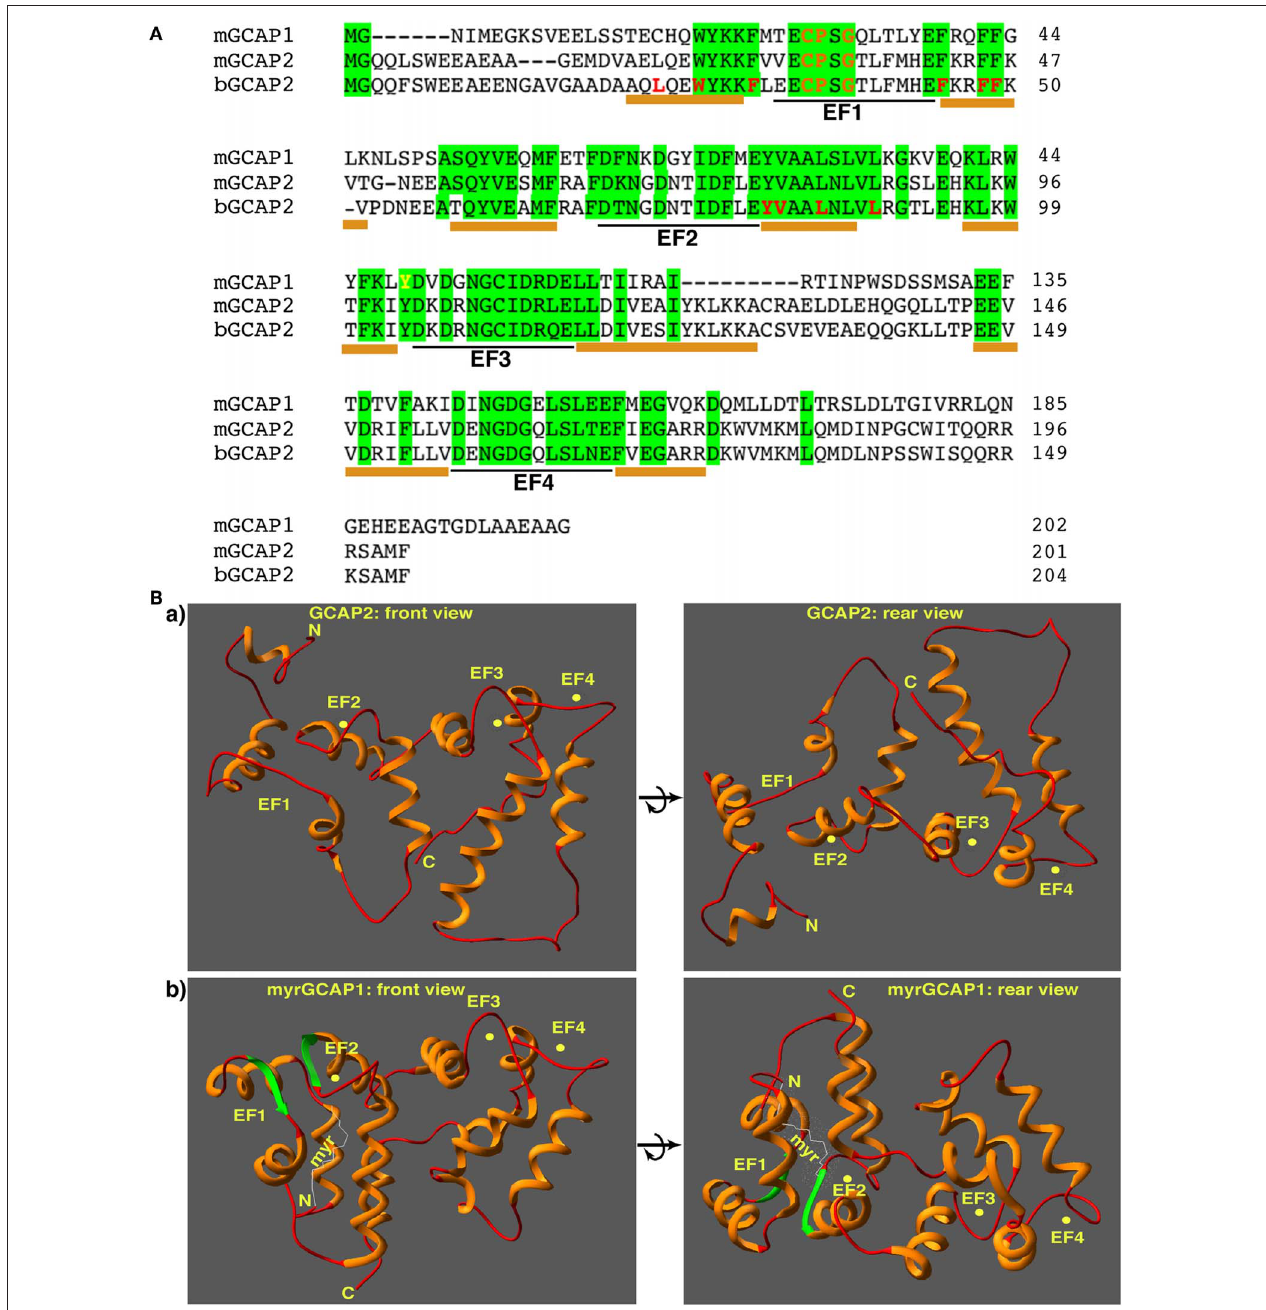
[Venkatesan et al. (2010)]. Amino acids in GCAP2 highlighted in red appear to be involved in the interaction with ROS-GCs [Ames et al. (1999)]. Residues in the loop region of EF1 that are incompatible with Ca 2 + -chelation and also involved in ROS-GC target interaction are shown in orange [Ames et al. (1999); Hwang et al. (2004)]. Abbreviations: mGCAP1, mouse GCAP1; mGCAP2, mouse GCAP2, bGCAP2, bovine GCAP2. (B) Structure of unmyristoylated GCAP2 (a) [Ames et al. (1999); pdb-file: 1jba] and myristoylated GCAP1 (b) [Stephen et al. (2007); pdb-file: 2R2I]. The structure is shown from the front (left) with the Ca 2 + -chelating loops on top as well as from the back (right) to document the location of the CTR region that binds to RIBEYE(B) in the case of GCAP2 [Venkatesan et al. (2010)]. Ca 2 + ions are schematically depicted as yellow